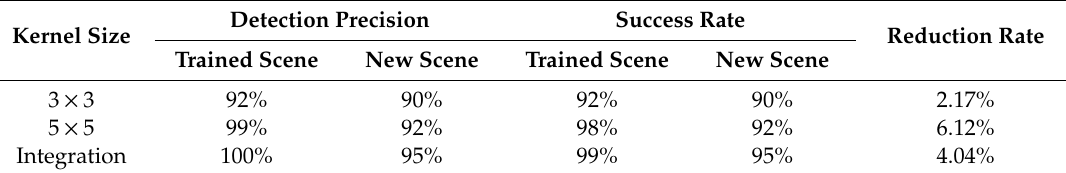
Table 2. The result with different kernels in the object detection network.